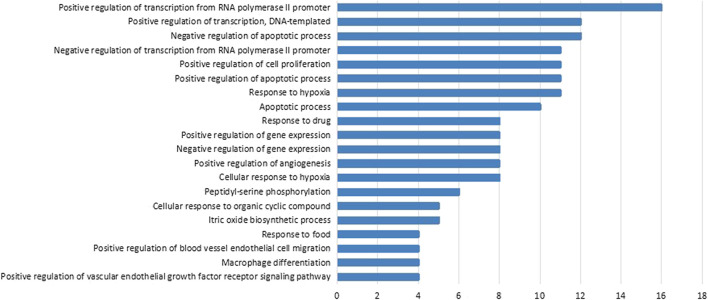
Biological processes regulated by WFC to treat PLGC. The count of each biological process was shown on the right side of the bar. The p-value of each biological process was less than 0.05. FDR of each biological process was less than 0.05.